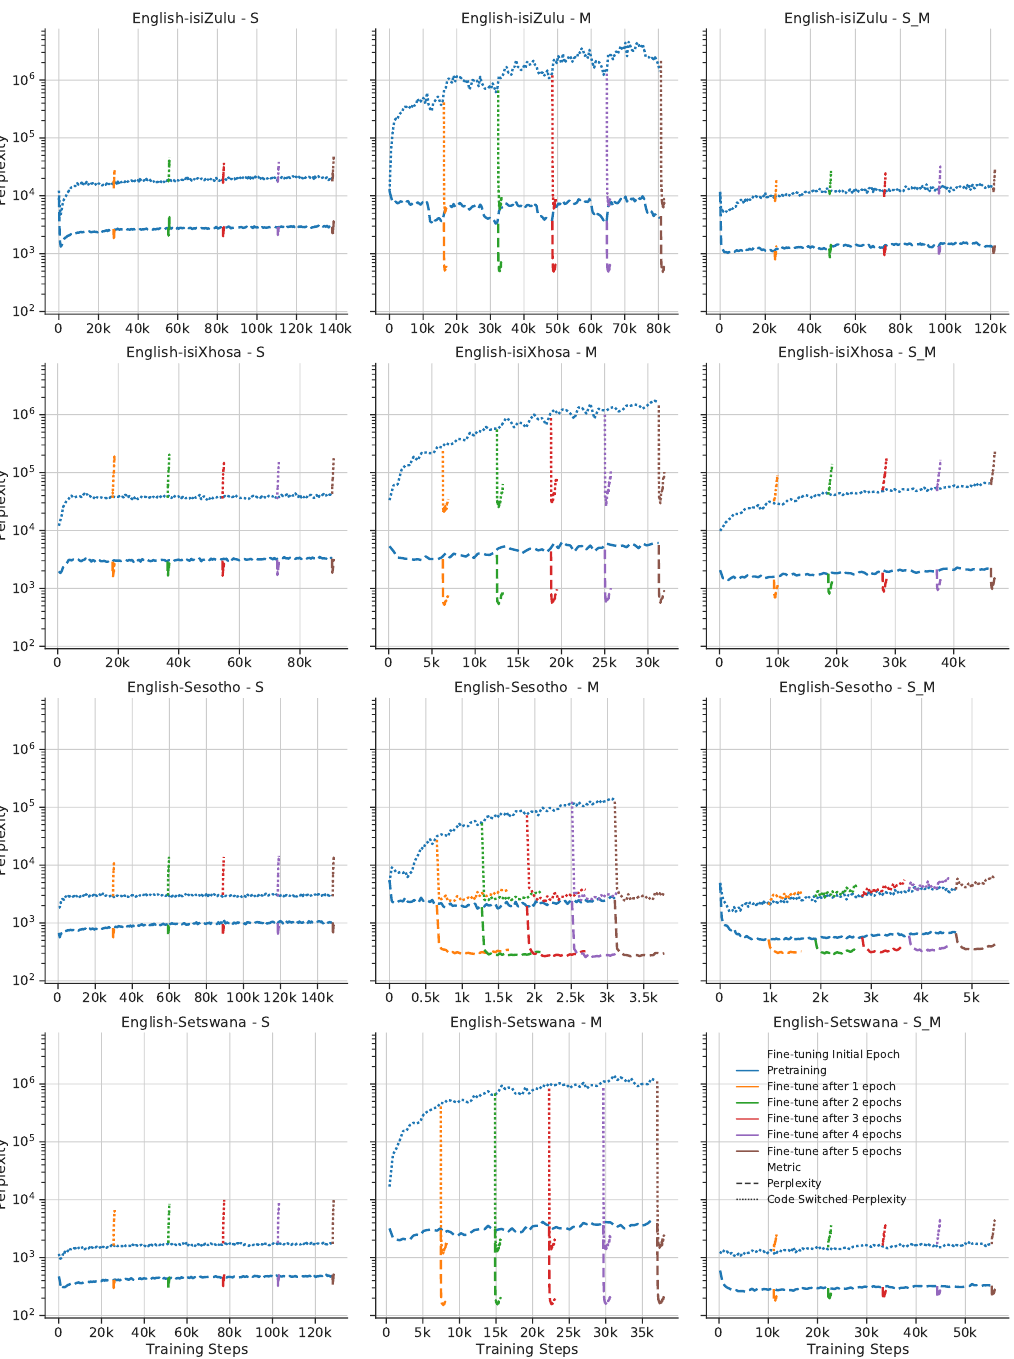
Figure 2. Development set perplexity and code-switched perplexity for each language pair (in rows: English–isiZulu, English–isiXhosa, English–Sesotho, and English–Setswana) and for each of the combinations of corpora used for pretraining as outlined in Table 4 (in columns: S: Synthesized, M: Monolingual, S_M: Synthesized and Monolingual). The red plot indicates the loss throughout pretraining, and each alternate colour corresponds to the loss when fine-tuning is started after pretraining for between one and five